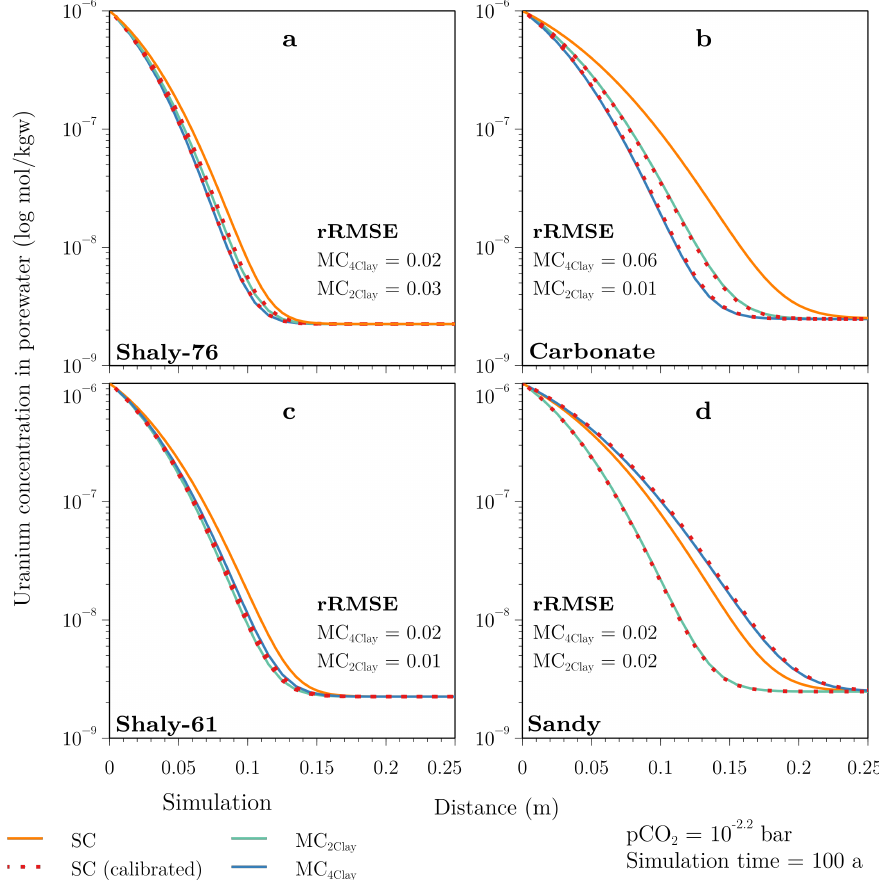
Figure 3. Concentration of uranium in the porewater of the shaly ( a , c ), carbonate-rich ( b ) and sandy facies ( d ) for the MC diffusion (MC 2 Clay , light blue line, and MC 4 Clay , dark blue line) as well as the SC approach (SC, orange line). The red, dotted lines represent the results of the simulations based on the SC approach using the K d and D e calibrated from the MC simulations. The rRMSE indicates the deviation between the simulations with the calibrated parameters and the respective MC simulation. The number behind the shaly facies corresponds to the clay mineral content in